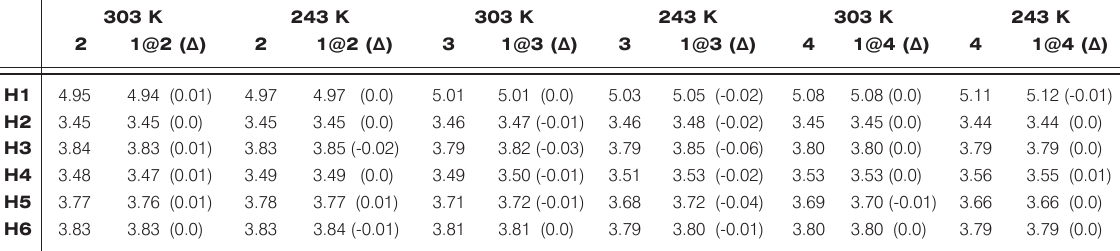
Table 1. Chemical shifts for free CD protons and those in the complex at room temperature and 243 K.